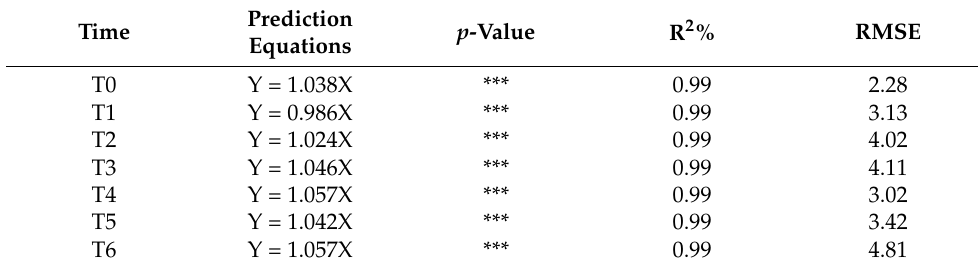
Table 3. Linear regression evaluating the relation between the estimated body weight and the real body weight using the validation group ( n = 13 rearing